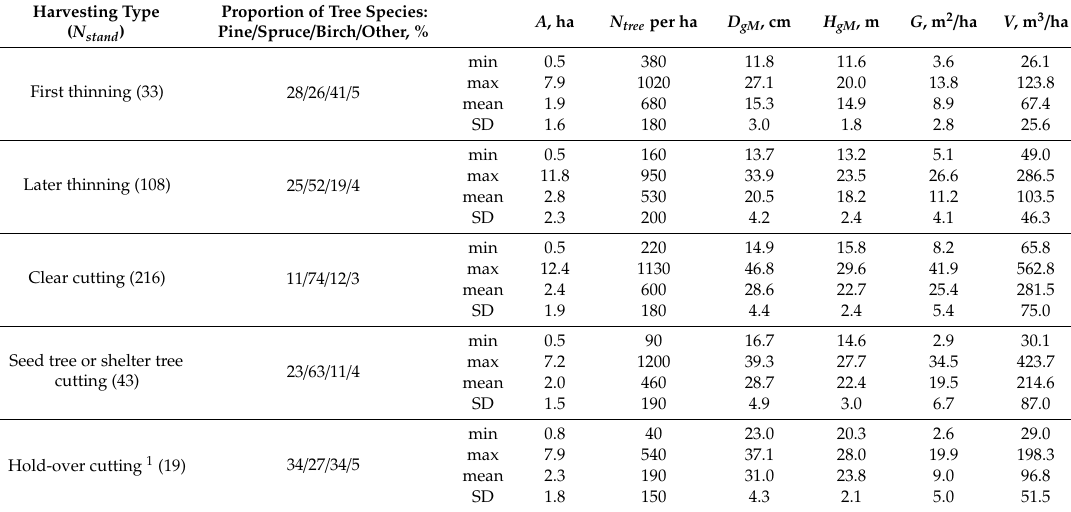
Table 1. The average total removal variables for harvested stands of this study, including only the stands over 0.5 ha. Other harvesting types that are not mentioned in table have been excluded. Number of stands in each harvesting type is denoted as N stand , and the number of harvested trees N tree is given per hectare. Abbreviations D gM and H gM stand for the mean basal area-weighted breast diameter and tree height, respectively. Variables G and V note the basal area and total volume. Abbreviation SD notes standard